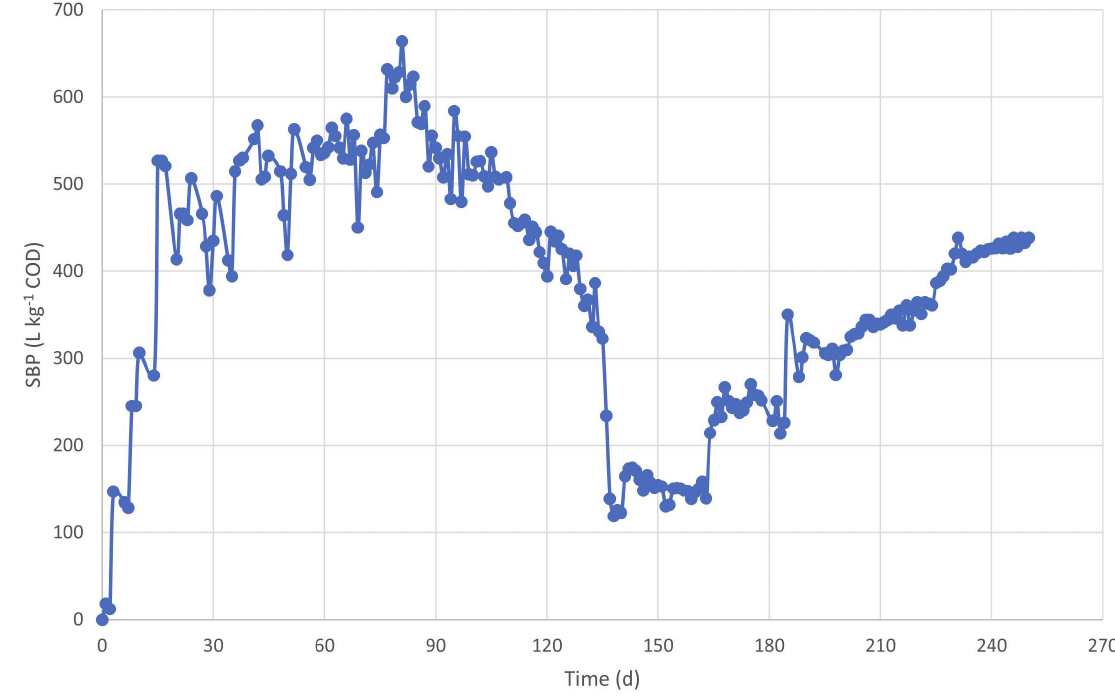
Fig. 3 – Specific biogas production